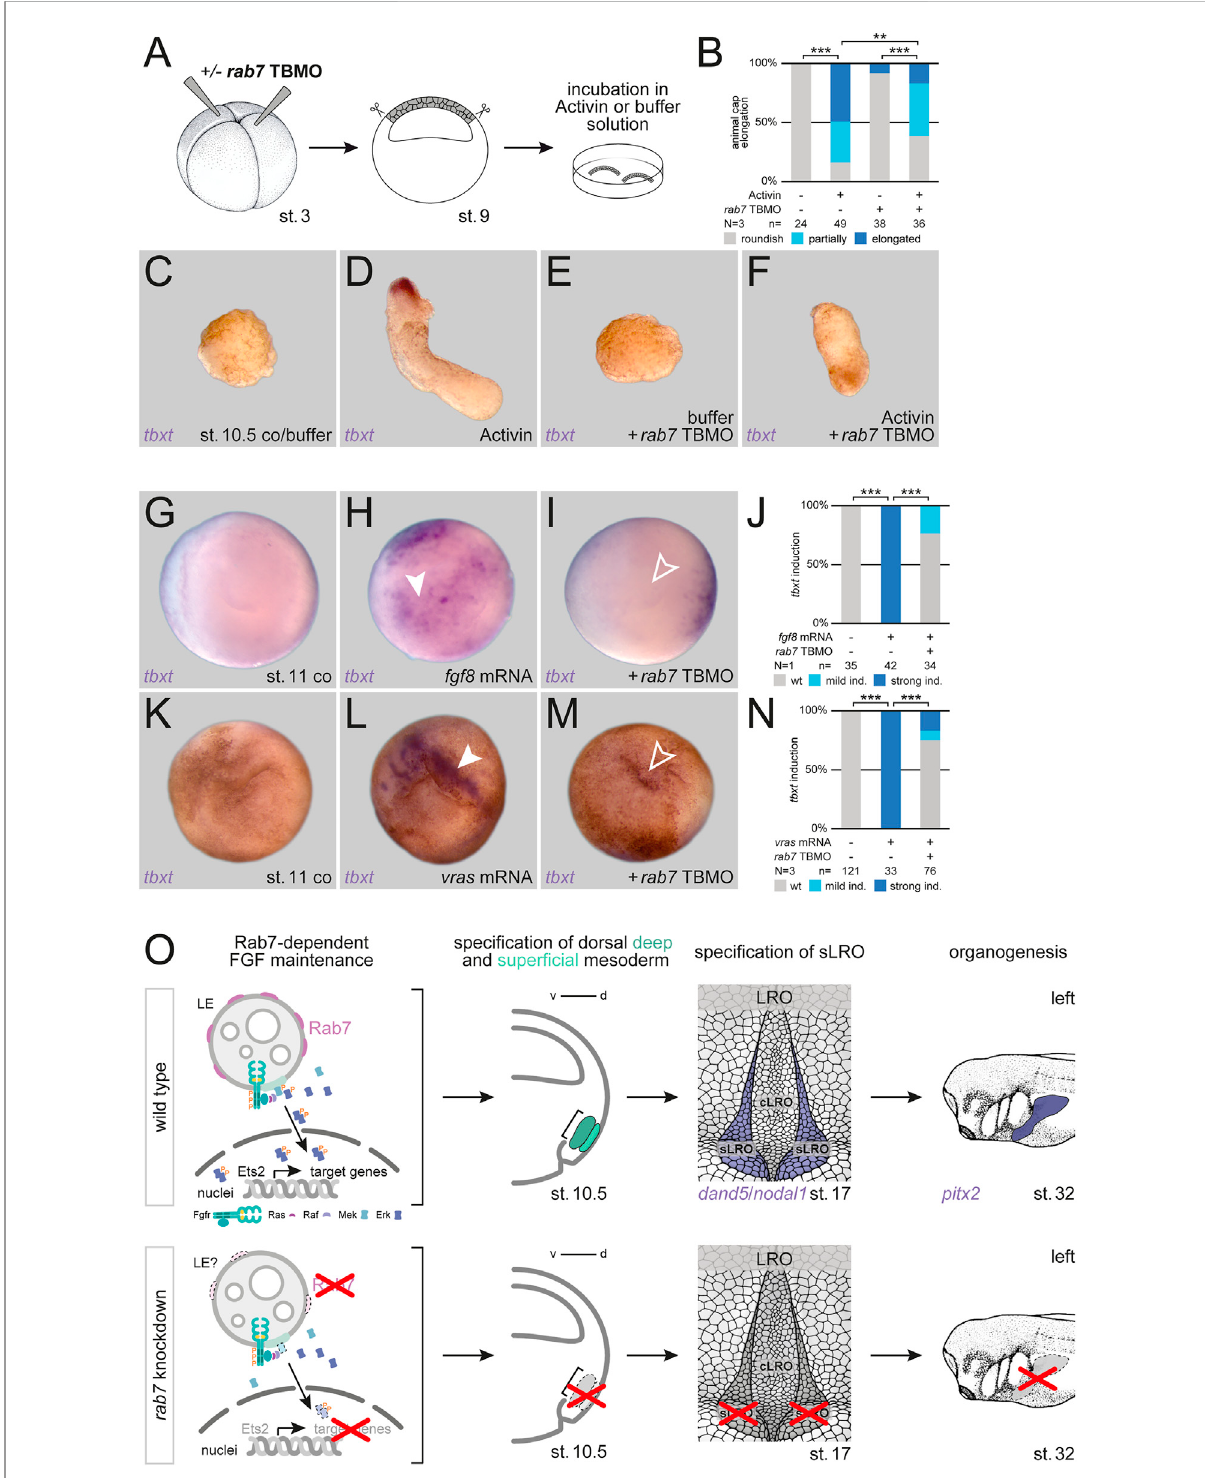
FIGURE 4 Rab7 is required for FGF-dependent mesoderm induction. (A) Experimental setup for theshown animal cap elongation assay: Injection atfour- cell stage (left) targeted the animal hemisphere, at st. 9 animal caps were dissected (middle) and incubated in Activin A or buffer solution (right). (B) Quanti fi cation of animal cap elongation. (C) Untreated animal caps (D) elongated upon Activin treatment. (E) rab7 -de fi cient, untreated animal caps remained in a roundish shape, (F) treated ones depicted partial or complete inhibition of elongation. (D) tbxt expression was only observed in